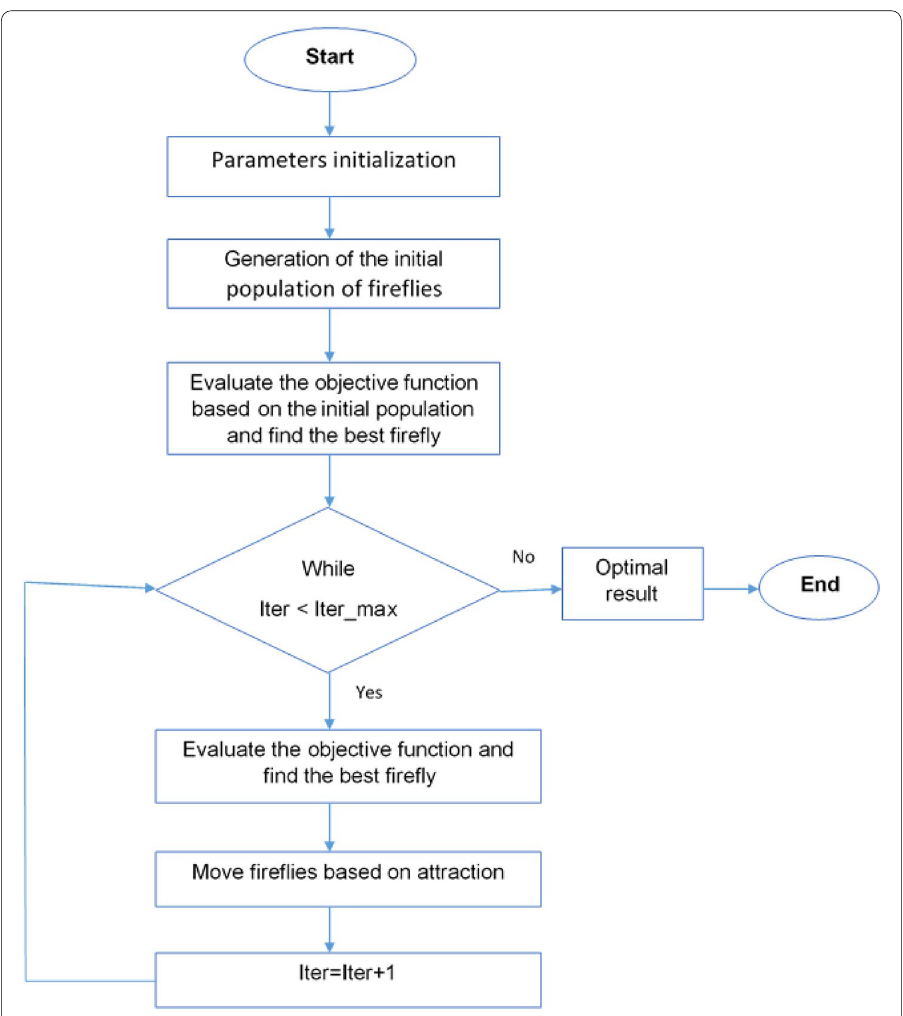
Fig. 3 Flowchart of firefly